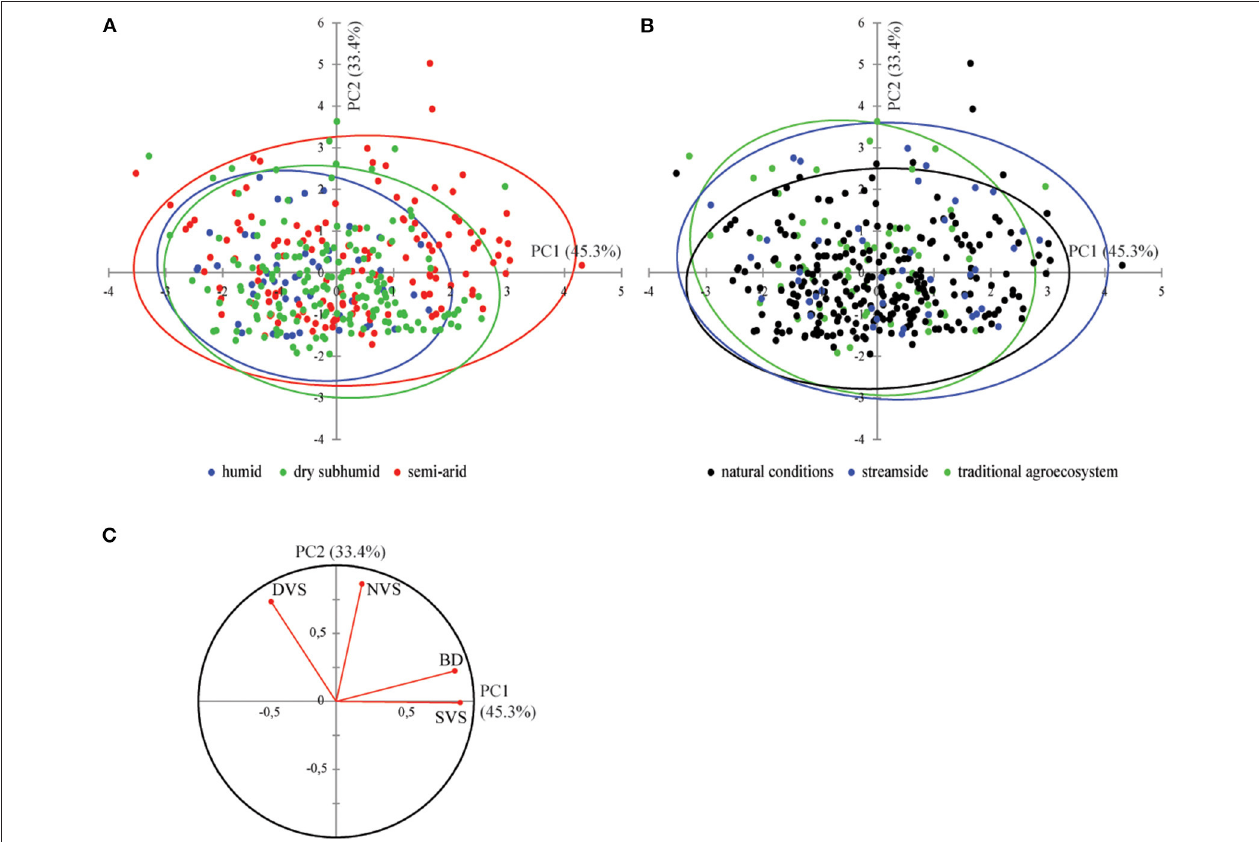
FIGURE 3 | Principal component analysis biplot of axes 1 and 2 (78.7% of variability) of wood olive samples belonging to different categories [ (A) bioclimatic conditions and (B) growing conditions]. Correlations among anatomical traits [ (C) correlation circle] and contribution of variables in the definition of PCA axes (C) are also